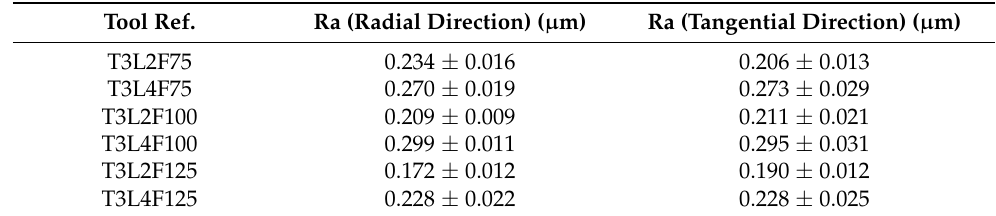
Table 10. Average surface roughness values, measured in the radial and tangential directions for the tests conducted with T3. Tool Ref.